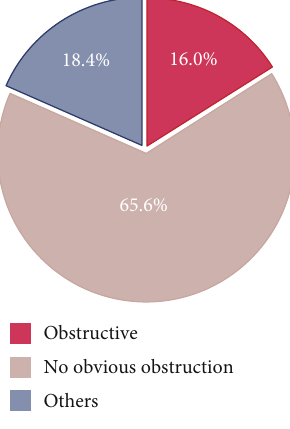
Figure 2: Overview of cranial ultrasound patterns in 125 infants with hydrocephalus.